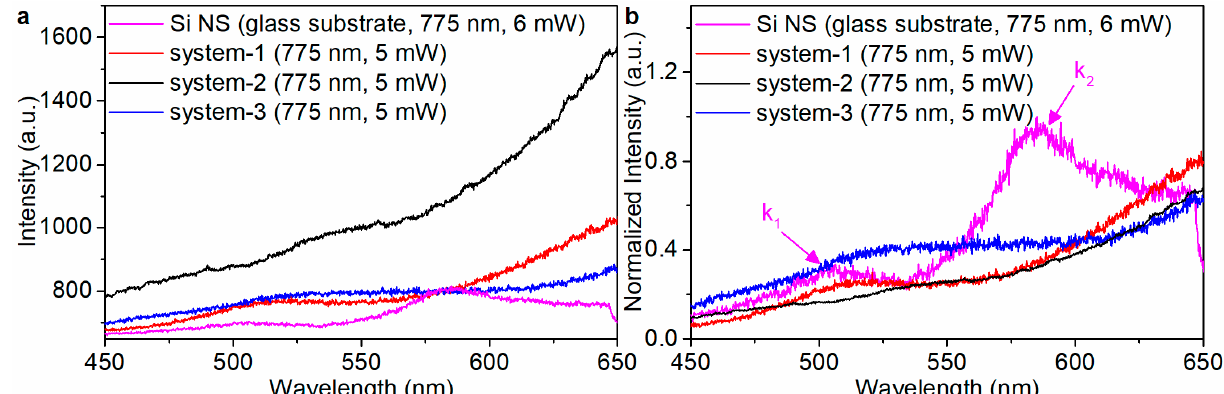
Figure 3. ( a ) The luminescence spectrum contrast diagram of the Si NS (pink line) and the Si@Pd core ‐Ω shell nanocavity at glass (red line, system ‐ 1), Au (black line, system ‐ 2) and Si (blue line, system ‐ 3) substrates; ( b ) The normalized luminescence spectrum contrast diagram of the Si NS (pink line) and the Si@Pd core ‐Ω shell nanocavity at glass (red line, system ‐ 1), Au (black line, system ‐ 2) and Si (blue line, system ‐ 3) substrates.